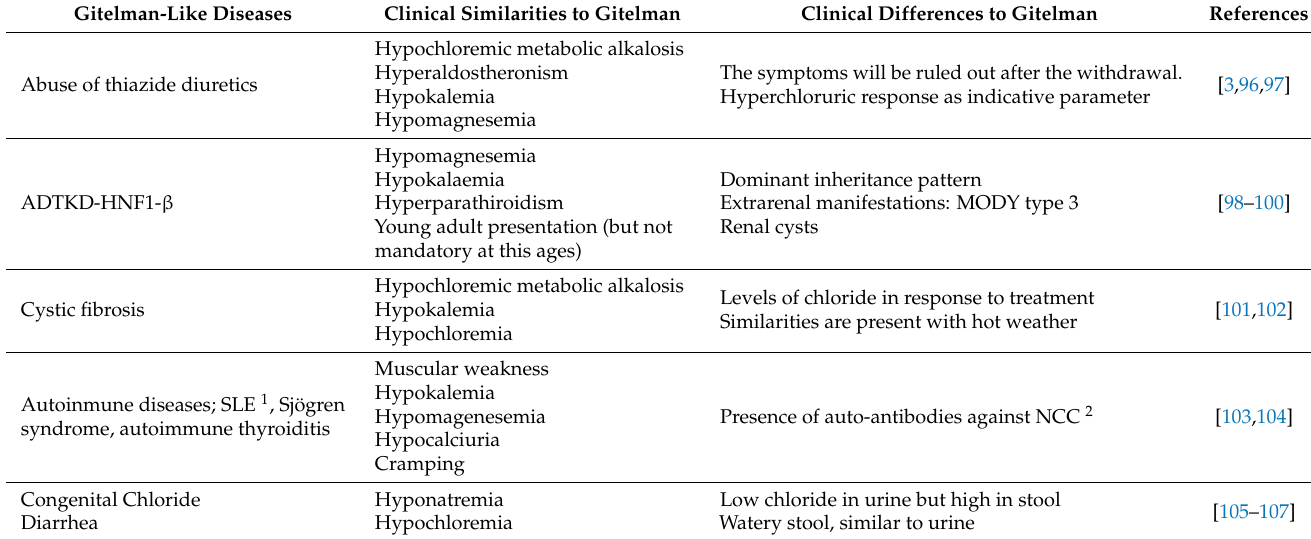
Table 2. Clinical entities that mimic Gitelman syndrome.